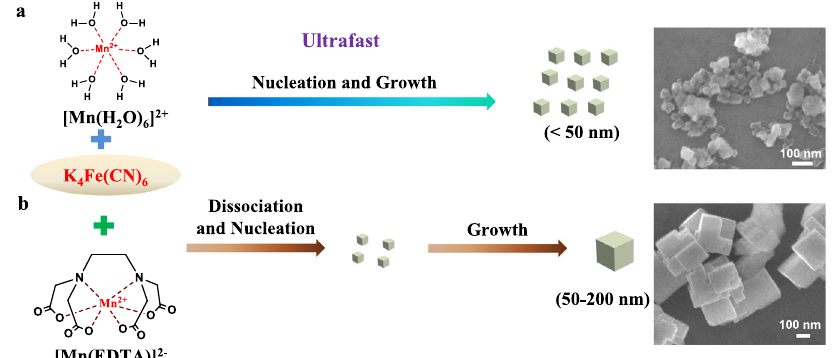
Fig. 1 K 2 Mn[Fe(CN) 6 ] synthetic pathways. Co-precipitation synthesis with no chelating agent ( a ) and with EDTA chelating agent (